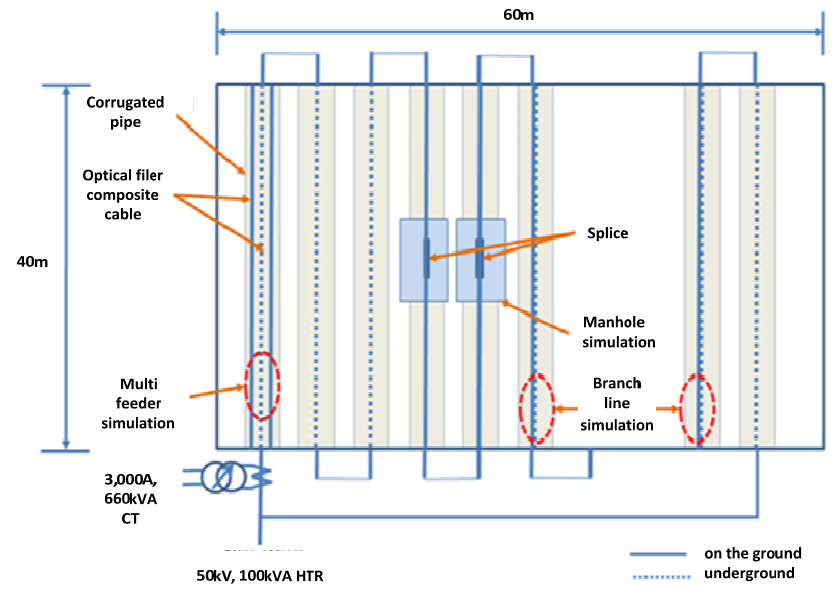
Figure 7. Test-bed configuration diagram.